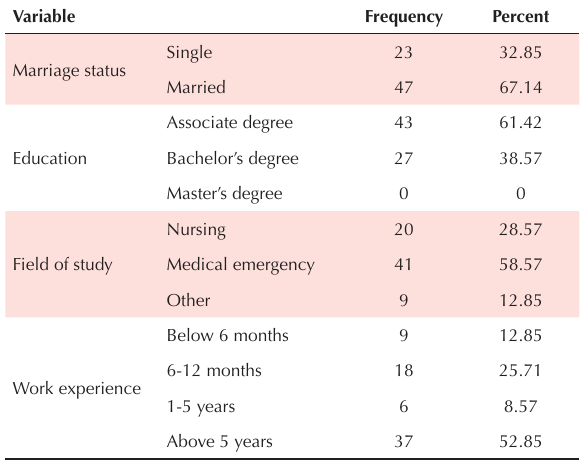
Table 1. Baseline information of